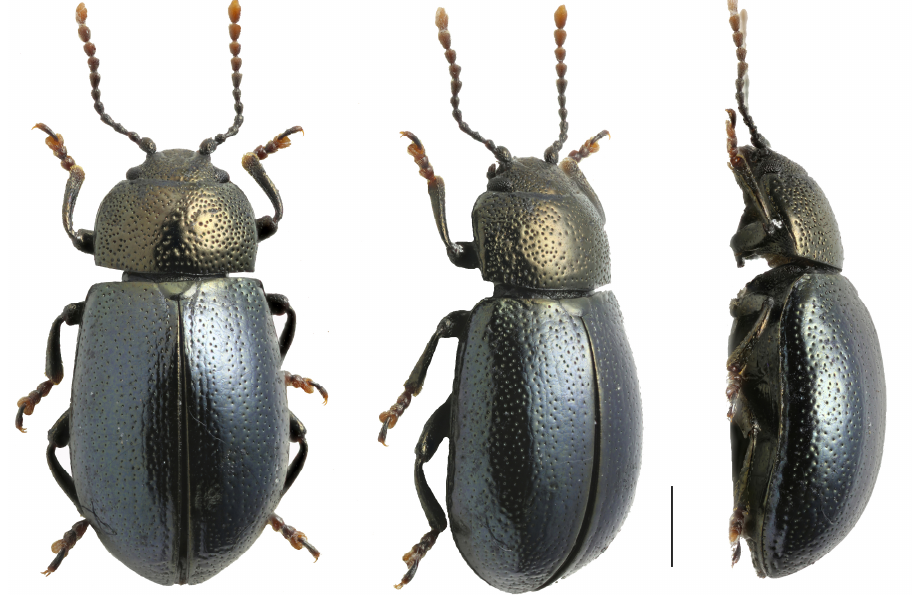
Figure 5. Apterocuris brinevi sp. n., holotype (Russia, Khabarovsk Province, Central Sikhote-Alin’ Mts)-habitus in dorsal, dorsolateral and lateral view of. Scale bar—1 mm.